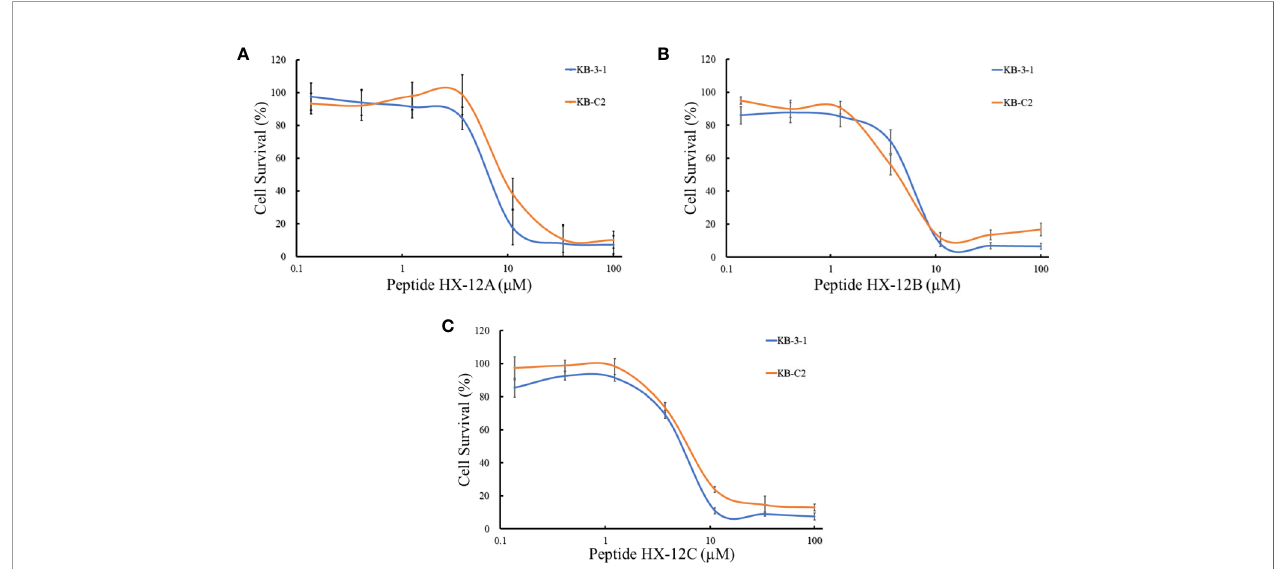
FIGURE 2 | The concentration-survival curves of three peptides HX-12A (A) , HX-12B (B) , and HX-12C (C) on drug-selected ABCB1-overexpressing cell lines (KB- C2) and their parental cell lines (KB-3-1) with gradient concentrations of peptide samples. Data points with error bars represent the mean ± SD from three independently repeated